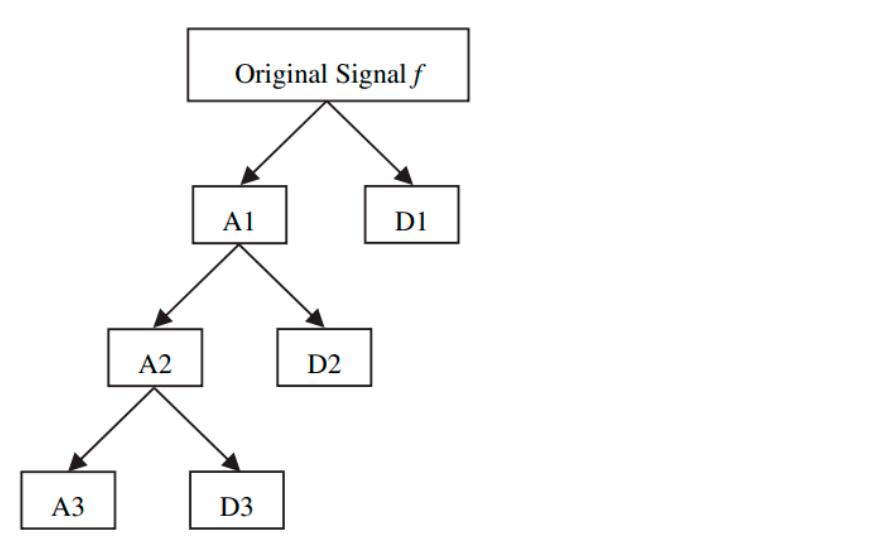
Figure 2. Wavelet transform decomposition process of the original signal. A wavelet function of type Daubechies of order 4 (abbreviated as Db4), which is used as the mother wavelet, along with three decomposition levels, is considered in this paper. The proposed methodology uses the approximation A3 and the details D3, D2 and D1 as